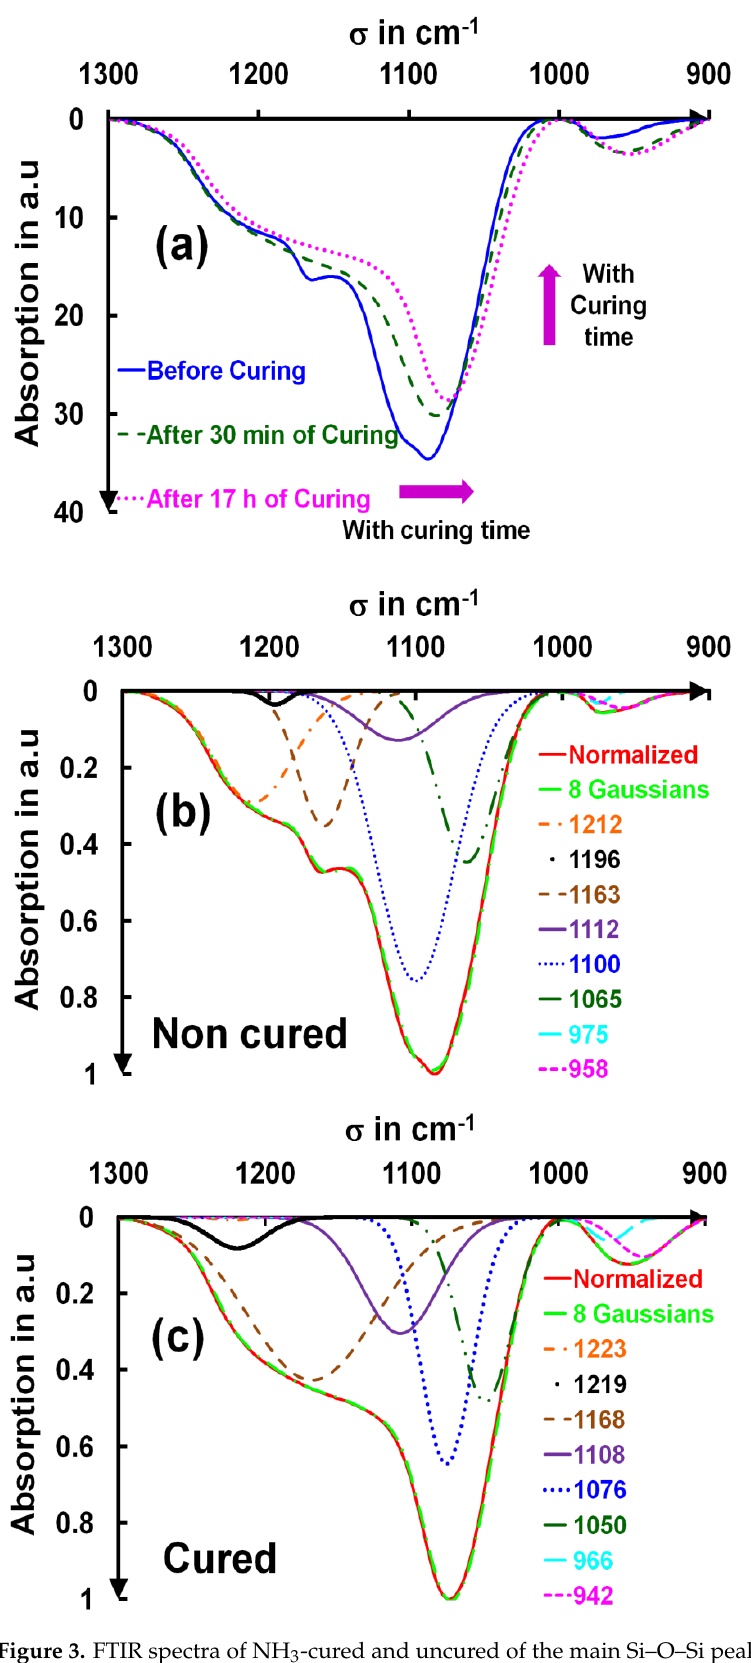
Figure 3. FTIR spectra of NH 3 -cured and uncured of the main Si – O – Si peak ( a ), decomposition of the Si – O – Si band into eight Gaussian contributions for a non-cured layer ( b ), and a cured layer for 17 h ( c ).